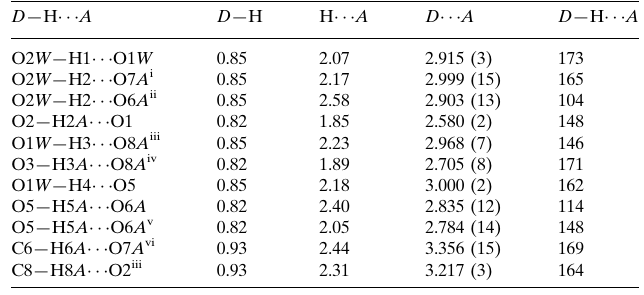
Hydrogen-bond geometry (A˚ , (cid:2)